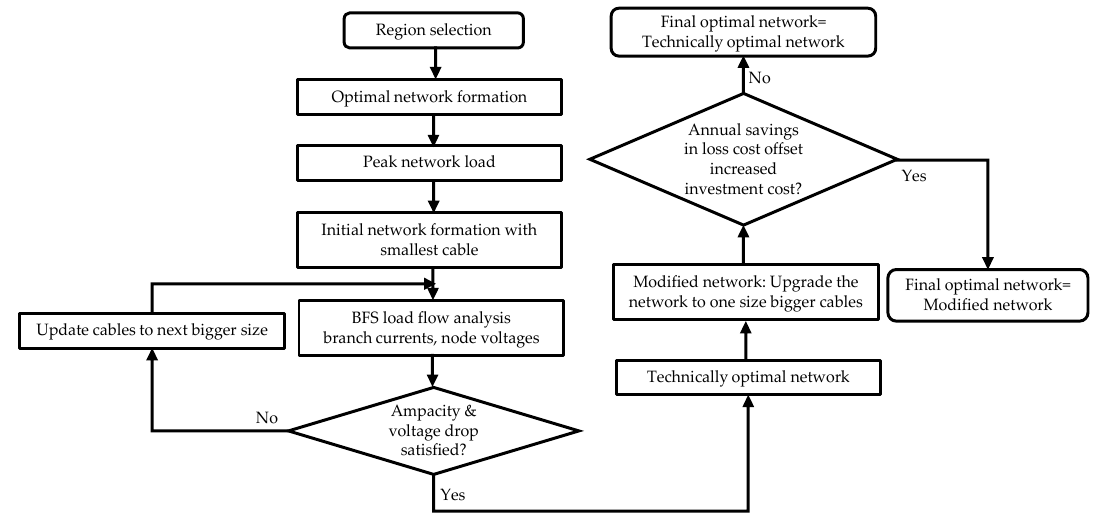
Figure 5. The optimal cable selection in terms of annualized investment and loss costs.